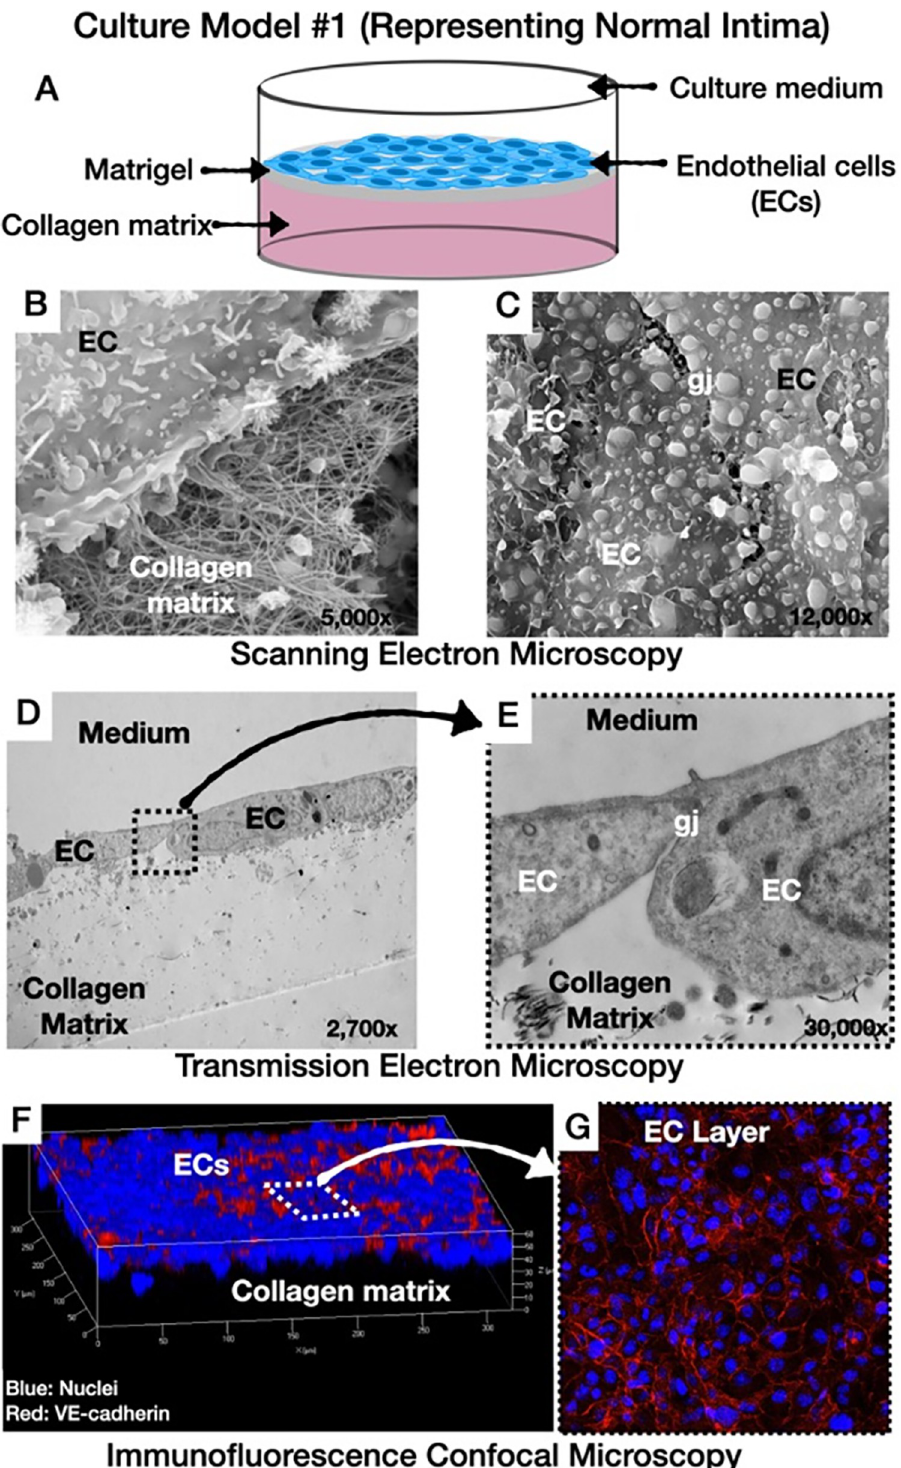
Fig 2. Culture model #1 representing normal arterial intima. A : Schematic illustration: Normal HCAECs cultured on top of Matrigel-coated collagen matrix, B and C : Scanning electron microscopic images showing the ECs monolayer with gap junctions and the underlying fibers of collagen matrix, D and E : Transmission electron microscopic images showing vertical section of the cultures F and G : 3D image of the culture by immunofluorescence